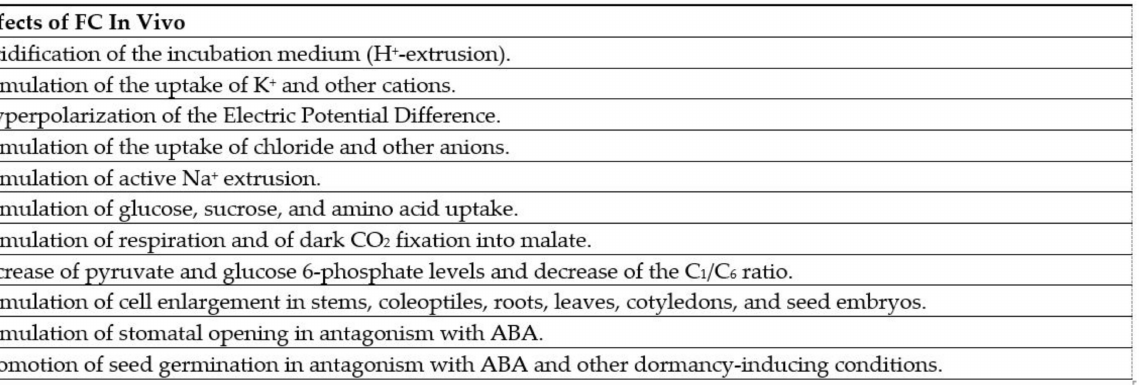
Figure 7. Reproduction of Table 1 of “Fusicoccin, a Tool in Plant Physiology” by Erasmo Marr è [61], reporting the main effects promoted by FC in vivo. ABA: absisic